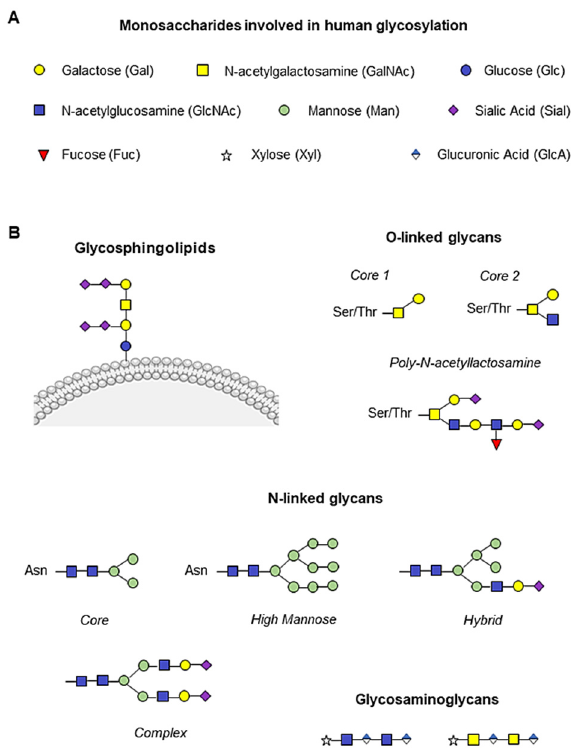
Figure 1. Human monosaccharides and their glycoconjugate forms. ( A ) Representation of the nine monosaccharides involved in human glycosylation. ( B ) Schematic illustration of glycan structures. Addition of N-acetylgalactosamine (GalNAc, yellow square) to serine/threonine (Ser/Thr) residues initiates O-glycan synthesis, while two N-acetylglucosamine (GlcNAc, blue square) and three man- nose (Man, green circle) constitute the N-glycan core, and the glycosylation branches are formed by galactose molecules (Gal, yellow circle), GalNAc, GlcNAc, fucose (Fuc, red triangle) and the final sialic acid (Sial, purple rhombus). Glycosphingolipids are conjugated to the plasma membrane, whereas glycosaminoglycans are mainly composed of an initial xylose (Xyl, white star) followed by glucuronic acid (GlcA, blue and white rhombus) and GlcNAc or